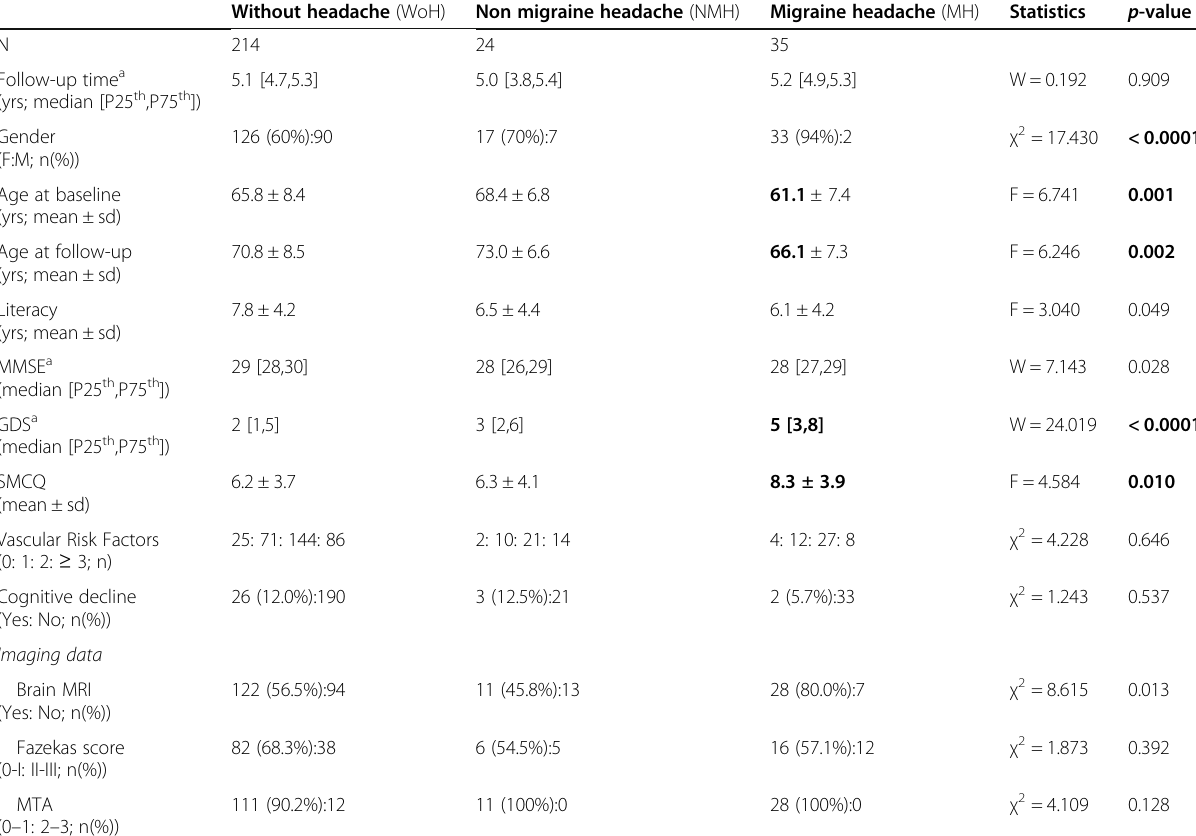
Table 1 Population characteristics by diagnosis Without headache (WoH) Non migraine headache (NMH) Migraine headache (MH)